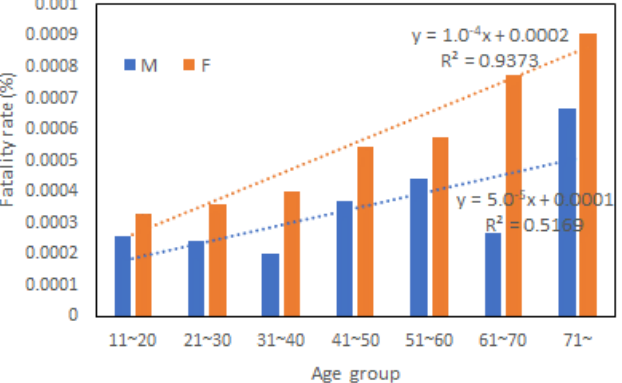
Figure 4. Relationships between age, gender, and fatality rates.